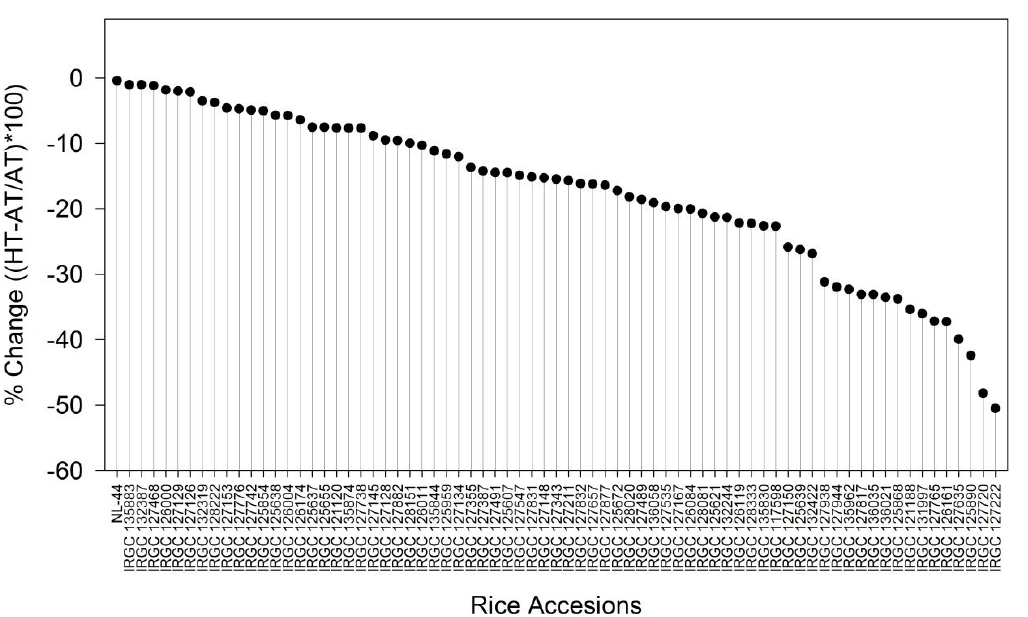
Figure 2. The box plot illustrates the phenotypic plasticity of ( a ) photosynthetic rate (Pn), ( b ) transpiration rate (E), ( c ) stomatal conductance (g s ), ( d ) substomatal CO 2 concentration (Ci), ( e ) photosynthetic water use efficiency (pWUE) and ( f ) Leaf width in rice accessions under both ambient-temperature (AT) and high-temperature (HT) conditions in experiment 1. The box plot represents the median values ( n = 3) for each trait of the 73 rice accessions. The black solid and dotted lines indicate the median and mean of all the rice accessions used in the study, respectively. Significance values were calculated and represented as p < 0.001 denoted by ***. Results that were not statistically significant are indicated as ns. Outliers are represented by closed circles.